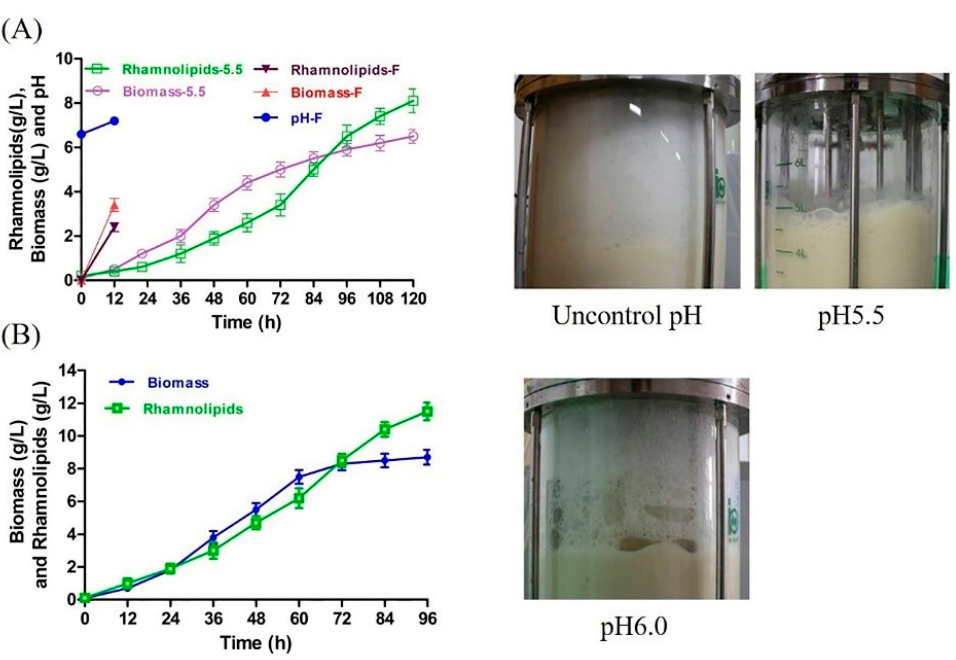
Figure 3. Rhamnolipid yield, biomass and digital images of rhamnolipid fermentation. ( A ) Rhamnolipid yield, biomass and digital images of fermentations carried out at uncontrolled pH and pH 5.5. Biomass-5.5 and rhamnolipids-5.5 represent the biomass and rhamnolipid production at pH 5.5, respectively; Biomass-F, Rhamnolipids-F and pH-F represent the biomass, rhamnolipid production and pH at uncontrolled pH, respectively. When fermentation was carried out in fermenter without pH control, excessive foam overflowed from the effluent gas outlet of the fermenter, forcing the fermentation to stop at 12 h. ( B ) Rhamnolipid yield, biomass and digital images of fermentation at pH 6.0.